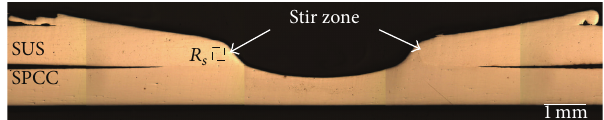
Figure 3: A cross-sectional macrograph of a SUS/SPCC FSSW joint.